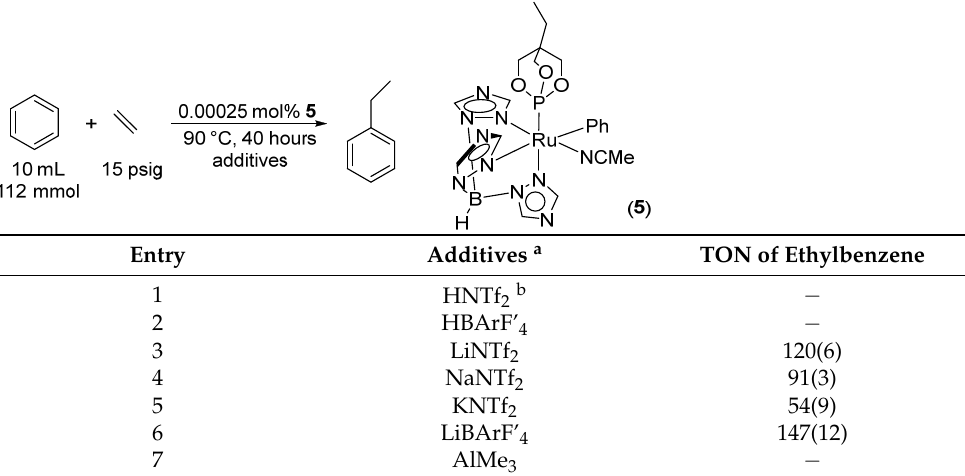
Table 1. Effect of additives for ethylene hydrophenylation catalyzed by (Ttz)Ru(P(OCH 2 ) 3 CEt)(NCMe)Ph ( 5 ).